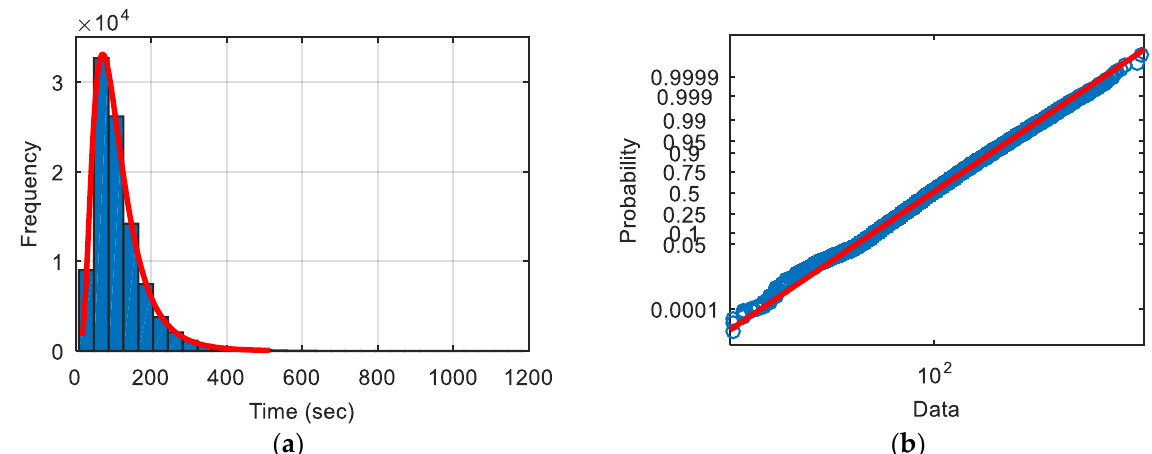
Figure 8. Triage data: ( a ) histogram; ( b ) probability plot (blue circles — real data, red line — theoretical distribution).